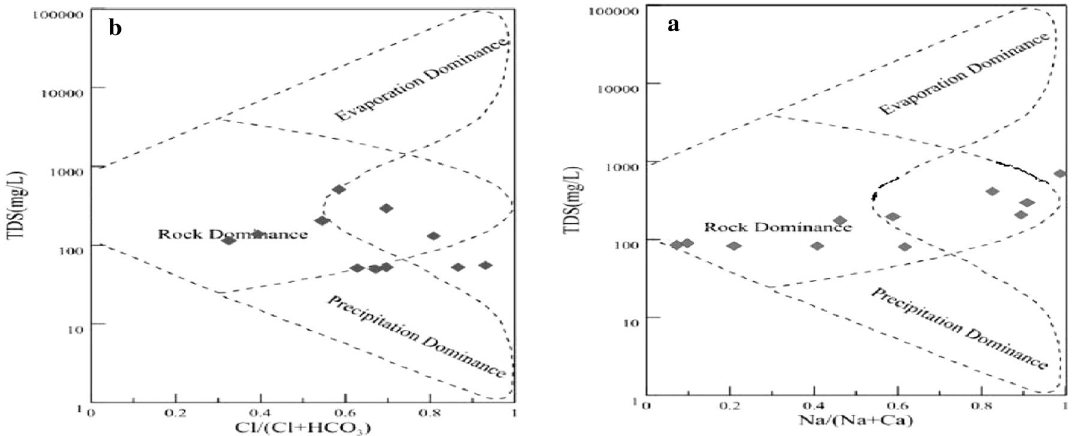
Fig. 4 Gibbs (1970), diagram showing the Ajali River water chemistry